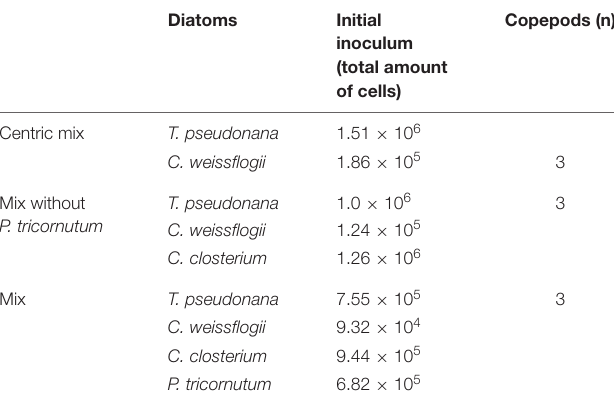
TABLE 1 | Composition of the 3 mixed diatom cultures: algal species, number of algal cells and copepods added to 50 ml of cultures. Diatoms Initial Copepods inoculum (total amount of cells)